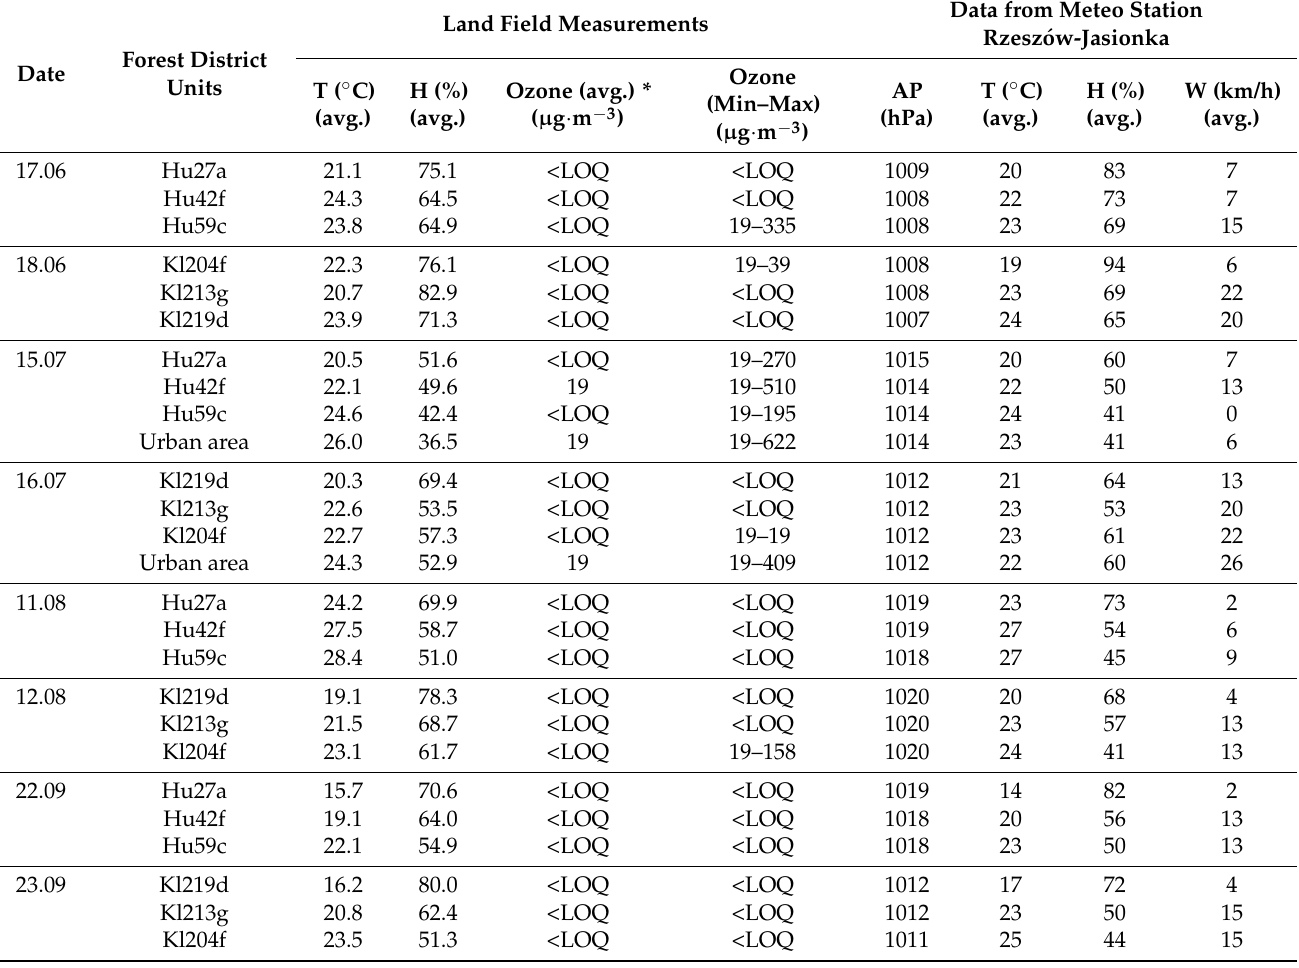
Table 2. Results of meteorological and tropospheric ozone